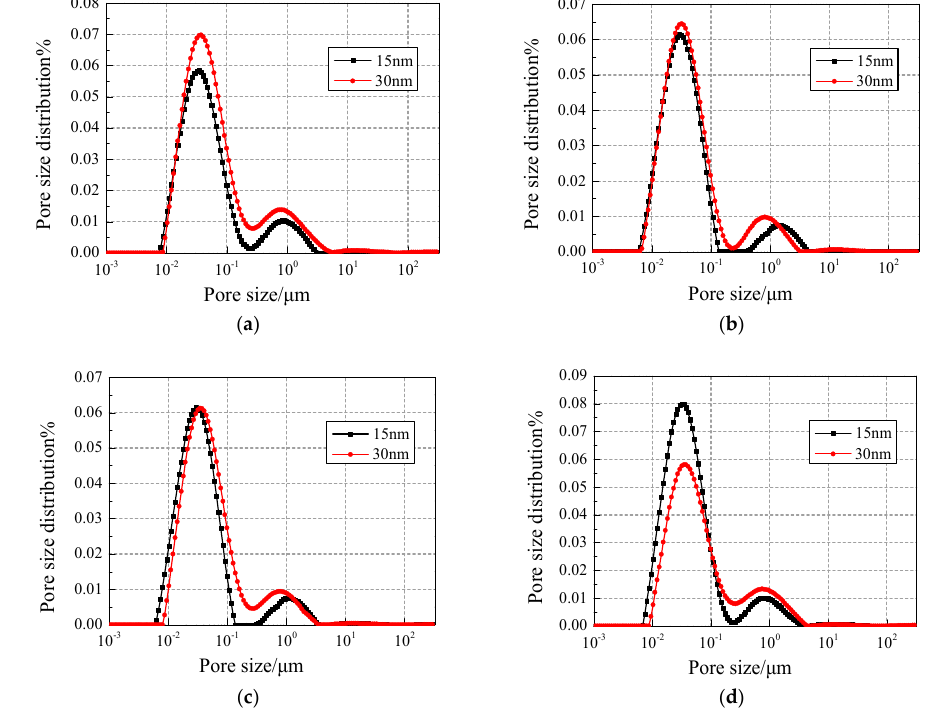
Figure 8. Pore fluid size distribution of NS specimens with different contents under 25 freezing and thawing cycles. ( a ) Content of 0.2%; ( b ) Content of 0.4%; ( c ) Content of 0.6%; ( d ) Content of 0.8%